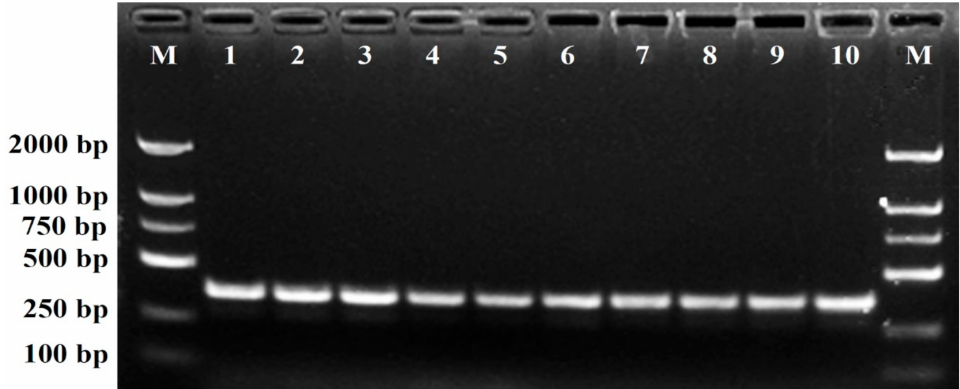
Figure 3. Amplification of the SCAR marker DBJF/DBJR primer pair developed in the genomic DNA of the 21 different C. morifolium cultivars (lanes 1–21). Lane M: Trans2K DNA marker with specified amplification product lengths (bp). A specific amplified band of 360-bp length was detected in the C. morifolium ‘Daboju’ sample.